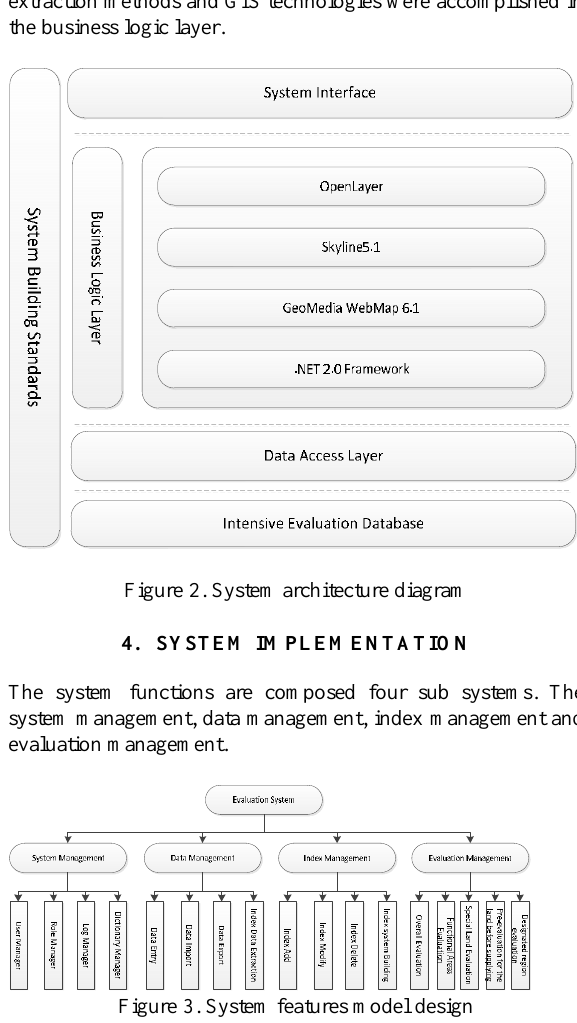
Figure 3. System features model